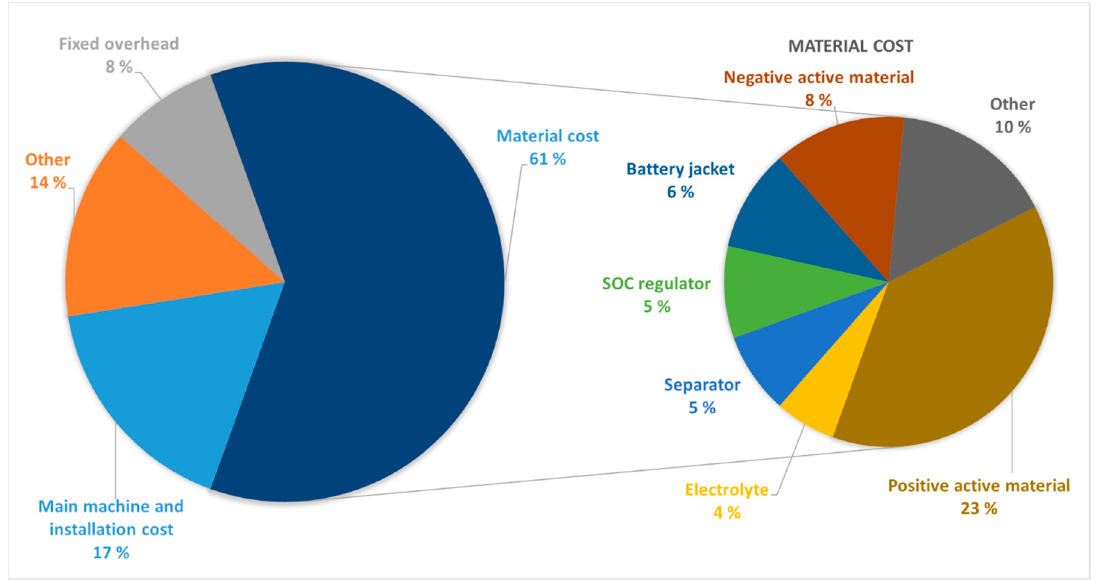
Figure 7. Breakdown of battery pack (high power cell) cost structure (Data from [72]).